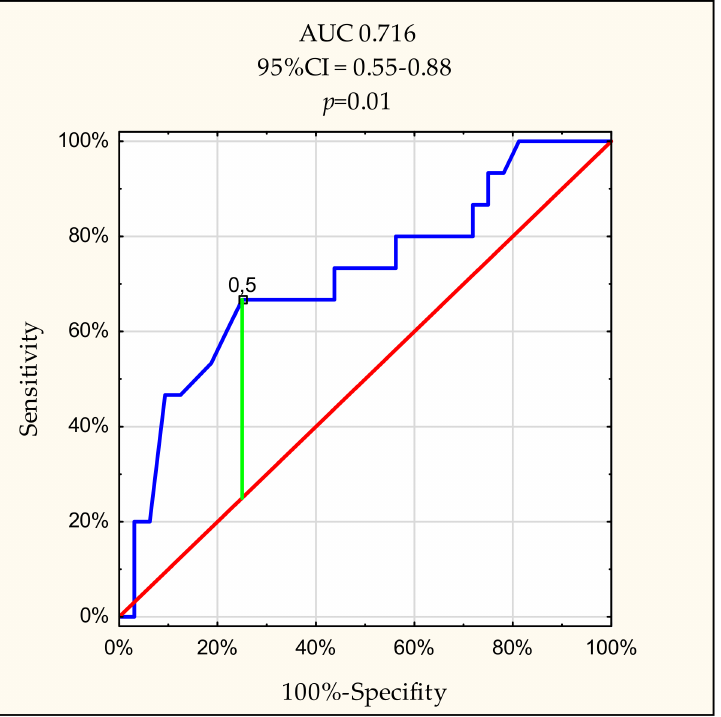
Figure 2. Receiveroperatingcharacteristiccurveof ∆ -HCO 3 − onthepredictionofGFR < 10 mL/min/1.73 m 2 in 49 CKD patients. The proposed cut-off point was ∆ -HCO 3 − = 0.5